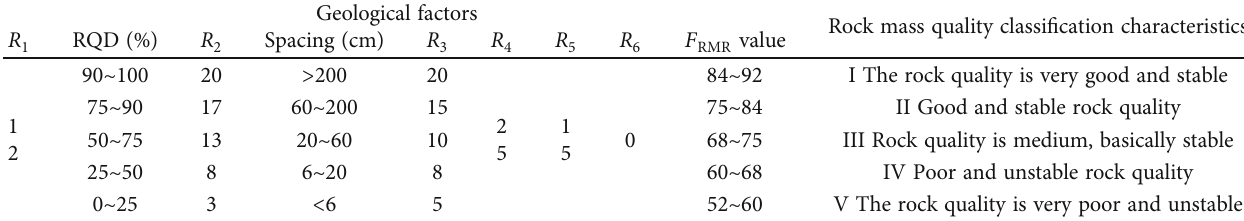
RMR for rock mass quality.